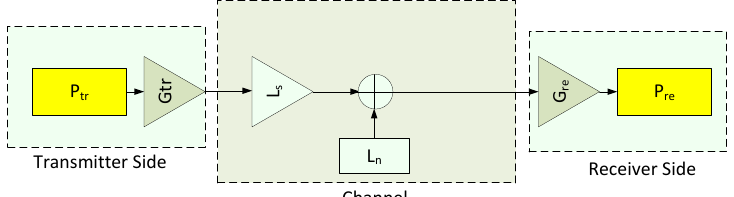
Figure 4. Block diagram of the link budget as expressed in Equation